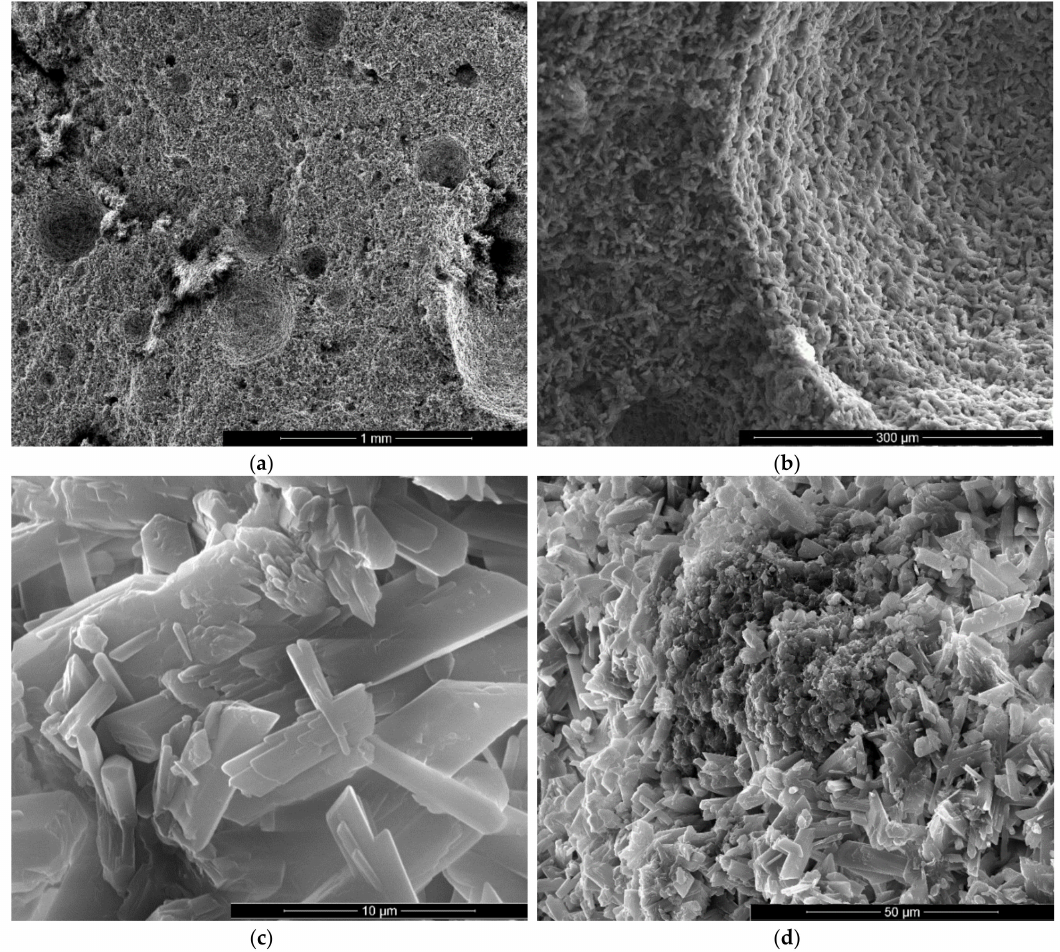
Figure 9. SEM images of gypsum binder with 1% FGD and 0.5% sodium bicarbonate addition (IG1B0.5) after 7 days of hardening in air, with various magnifications: ( a ) × 100; ( b ) × 500; ( c ) × 10000; ( d ) × 2000.